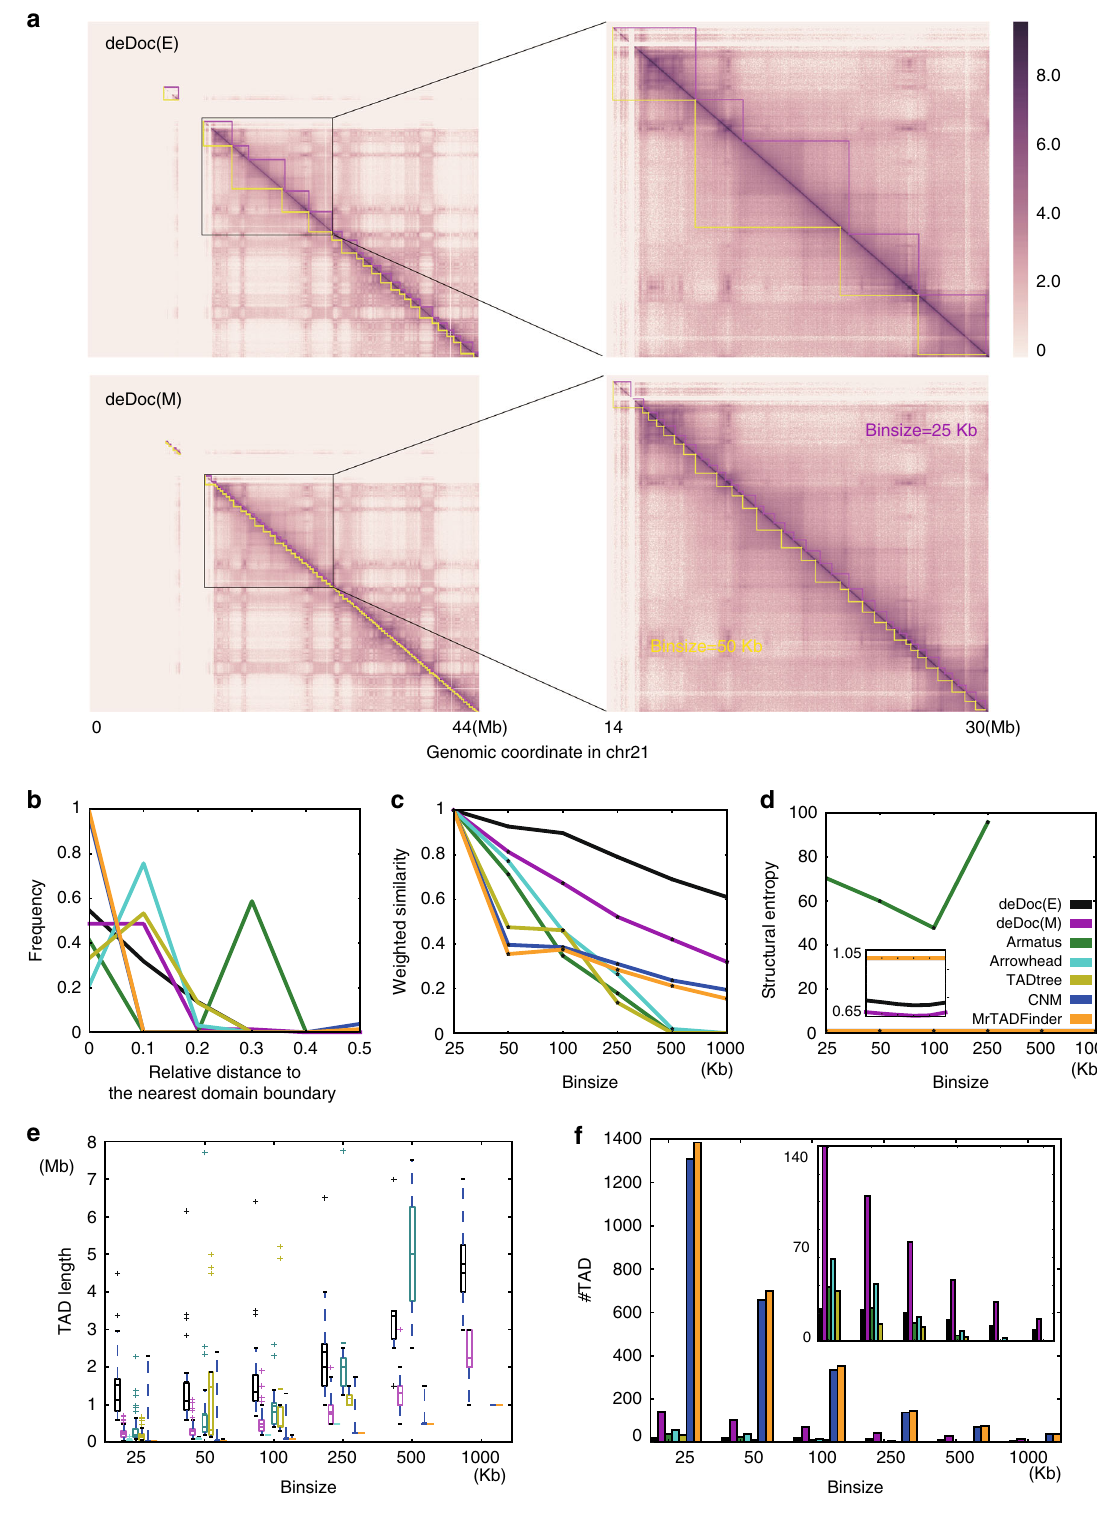
Fig. 3 Hierarchical structure of genomes as detected by deDoc using different binsizes. a Heatmap of nested domains as predicted by deDoc(E) and deDoc (M) in human chromosome 21 are shown at the top and bottom panels, respectively. The predicted domains were highlighted in magenta and yellow sawteeth for binsizes of 25 and 50 kb, respectively. The distribution of b the relative distance to the nearest TAD borders, c the weighted similarities, d the structure entropies, e TAD lengths, and f the number of domains as predicted by the different algorithms using different binsizes. Each curve represents the result from one algorithm, and the color code for the algorithms are found in d . Zoom-in plots are embedded. Data from human GM12878 cells (Rao et al. 21 ) were used to produce all plots in this fi gure. Box plot quartiles, and the means and medians of each dataset are indicated by black and magenta lines. The ends of the up and down whiskers represent the highest and lowest datum or 1.5 interquartile range of the upper and lower quartiles,